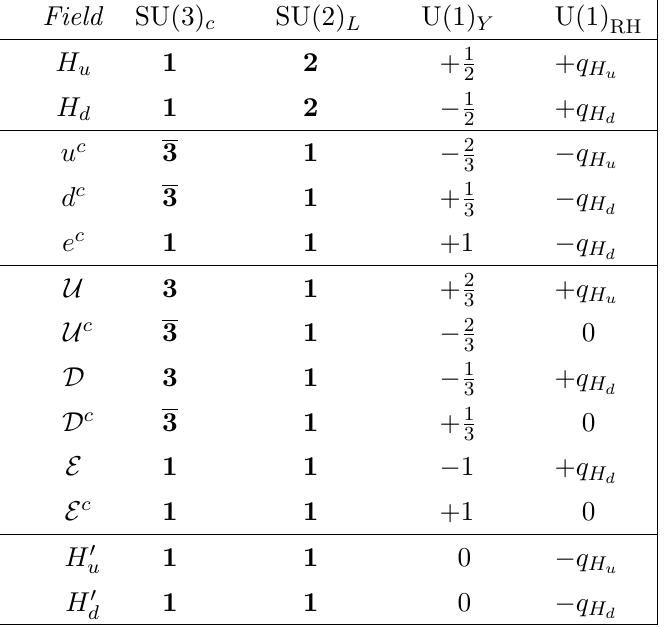
Table 1 . U(1) charge assignments for for a type-II 2HDM scenario. The SM (cid:12)elds Q and L are RH neutral under U(1) . Three generations of fermions are RH